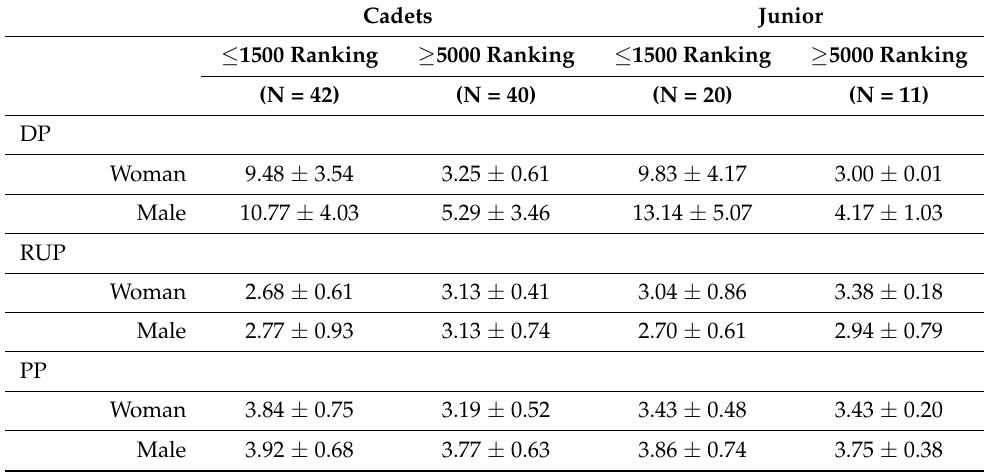
Table 6. Mean ± standard deviation of the weekly hours of Deliberate Practice (DP) and of the factors of the Motivational Persistence scale (RUP: Recurrence of unattained purposes and PP: Purposes pursuing) as a function of competitive level and category. Cadets Junior ≤ 1500 Ranking ≥ 5000 Ranking ≤ 1500